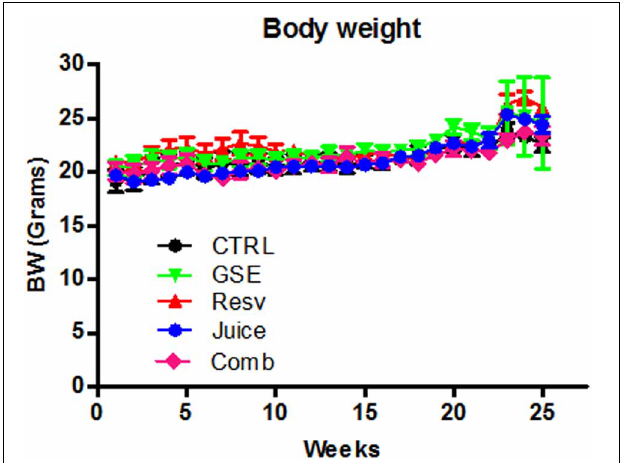
FIGURE 1 | Chronic Comb treatment has no adverse effect body weight measurements over the 5 month dietary treatment. Data represents mean ± s.e.m., n = 8 − 9 per l .